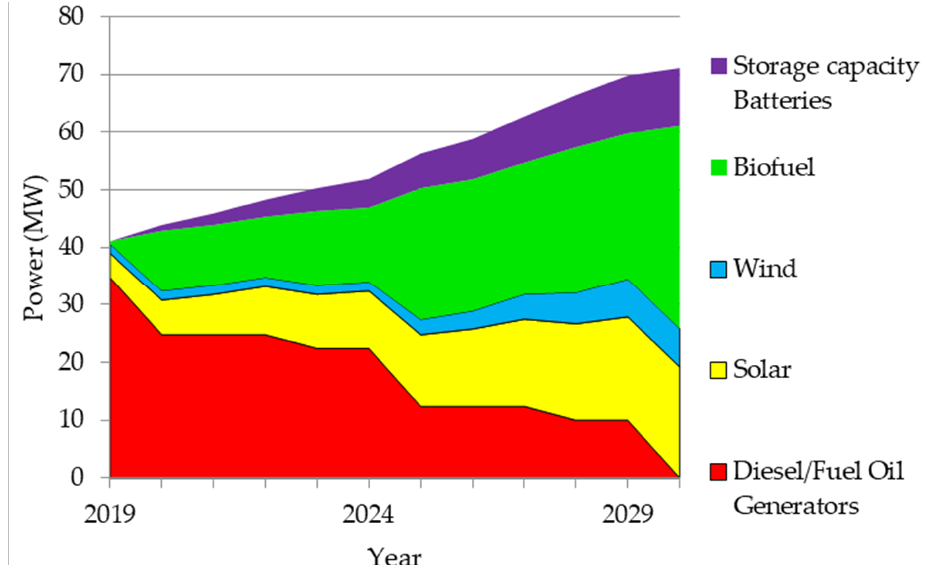
Figure 22. Power plant capacity on Isla de la Juventud for the MAXRES scenario. Source: own elaboration with the model.